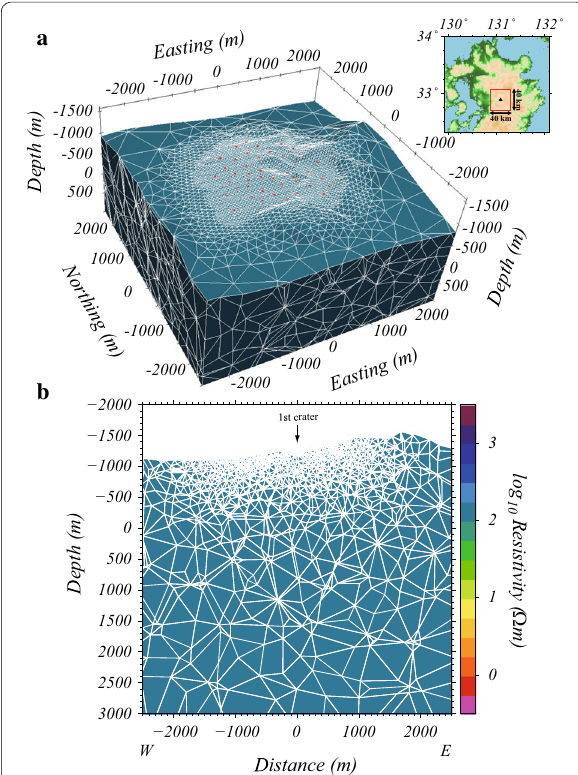
Fig. 2 Distribution of the tetrahedral mesh used for 3-D inversion in the survey area. a Surface mesh over an area of 5 km on the Nakadake first crater. The red dots indicate AMT sites. A resistivity value of 100 Ωm was given for each mesh cell as a starting model. The mesh for the air layer has been omitted to enhance the clarity of the graphic. b East–west cross section passing through the origin (the center of the Nakadake first crater). The mesh cell size is smaller closer to the ground and closer to the central